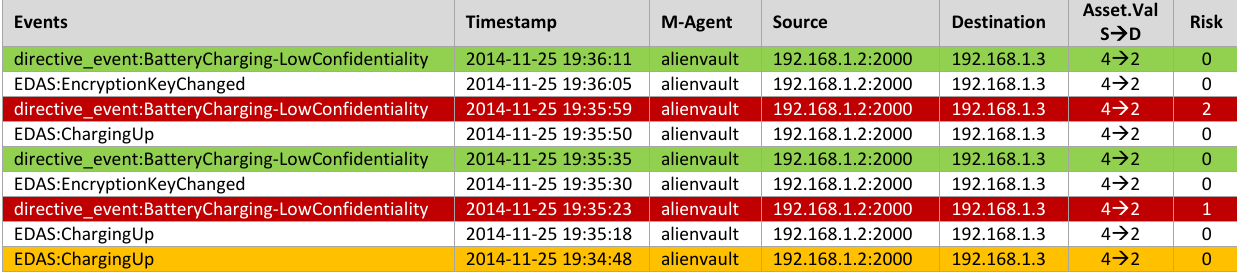
Figure 17. Scenario 2: EDAS platform dashboard screen (modified): the LowConfidentiality alarm is raised (as risk = 1, 2) whenever a BatteryChargingUp event is detected and is reduced when a Key Changed event is detected after adaptation. Color legend: yellow, trigger event; red, alarm (unacceptable risk); green, alarm (acceptable risk); white, event